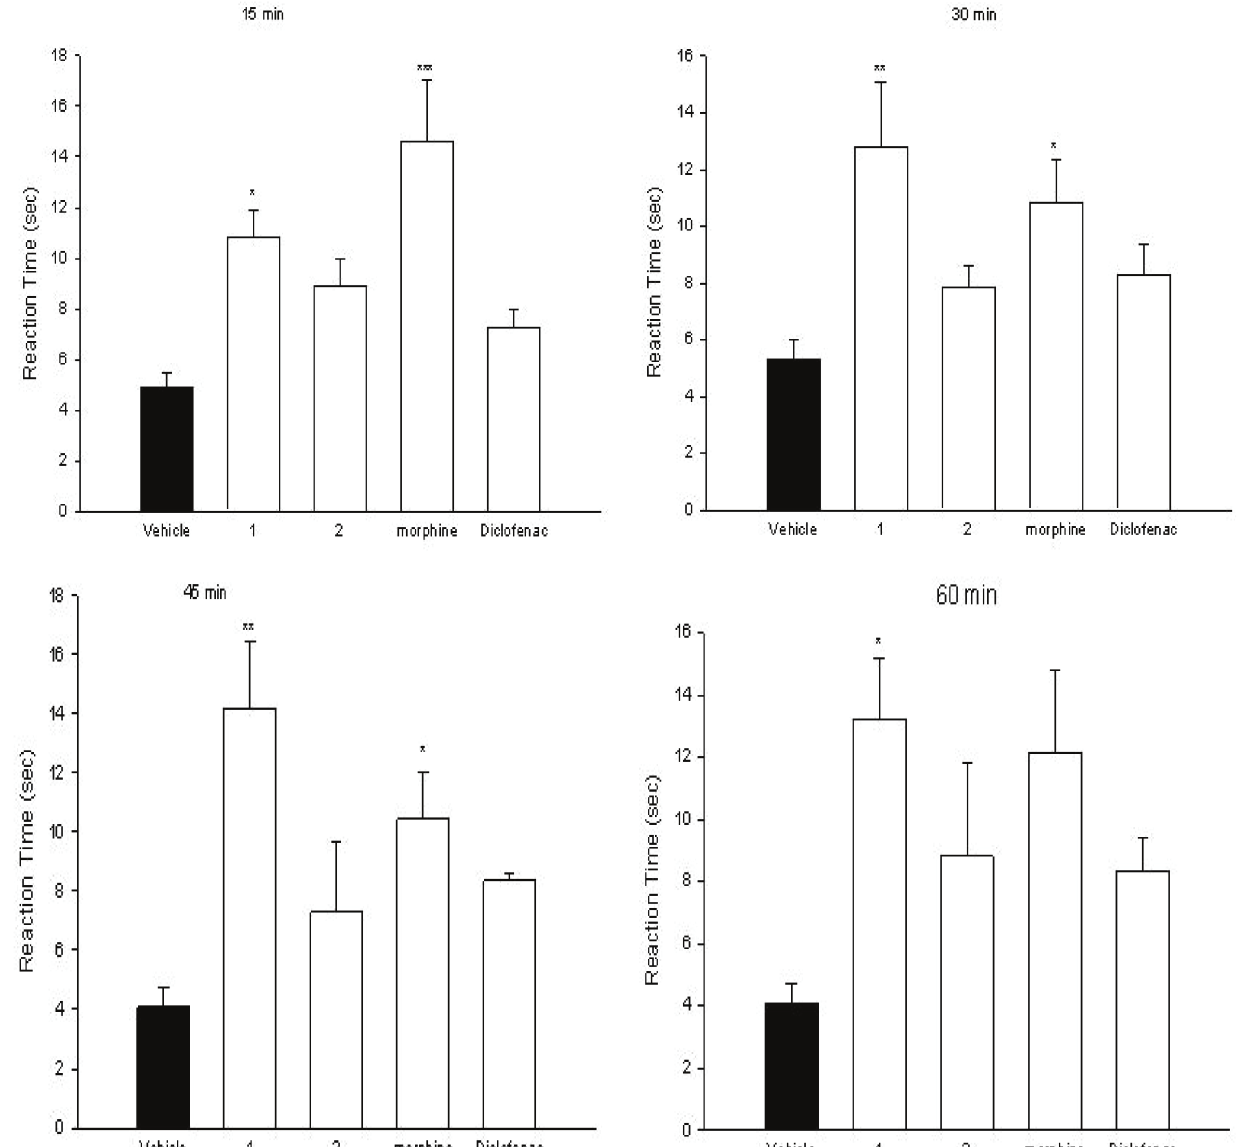
FIGURE 2 - Effects of A. sieberi (1 and 2 mg/kg) essential oil on the latency time (15, 30, 45 and 60 min) of mice exposed to the hot plate test. Each value represents the mean ± S.E.M. of eight mice. * P < 0.05, ** P <0.01 and *** P <0.001 compared to the control group using one-way ANOVA followed by Dunnett’s multiple comparison test.